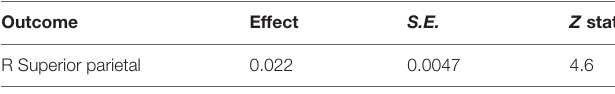
TABLE 4 | Summary of effects of body mass index on GM cortical thickness.